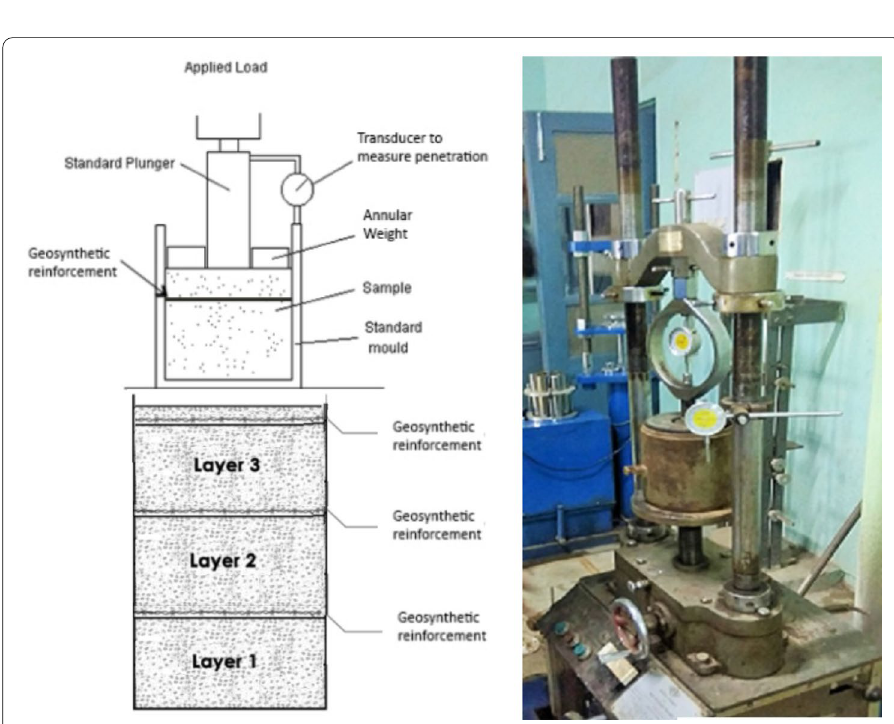
Fig. 5 CBR experimental setup and schematic arrangements of sample in